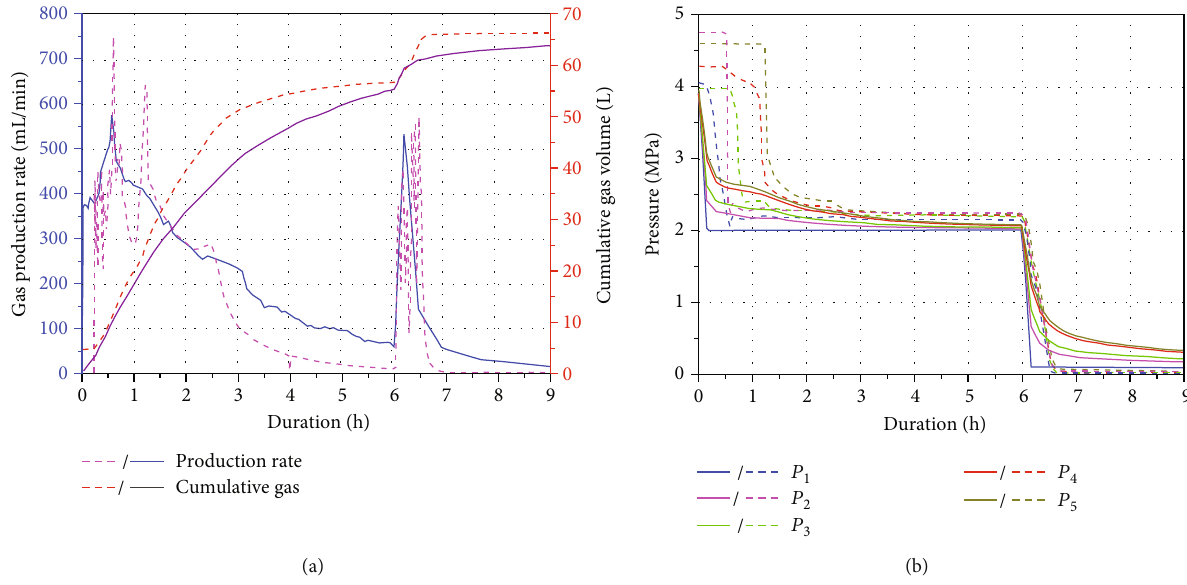
Figure 4: Comparison between the numerical results and experimental results for two-step multistage depressurization. (a) The gas production rate and cumulative gas production evolution behaviors with time. (b) The pressure evolutionary behaviors at di ff erent locations in the simulated formation. The dash lines represent experimental results, while the solid lines represent numerical results.